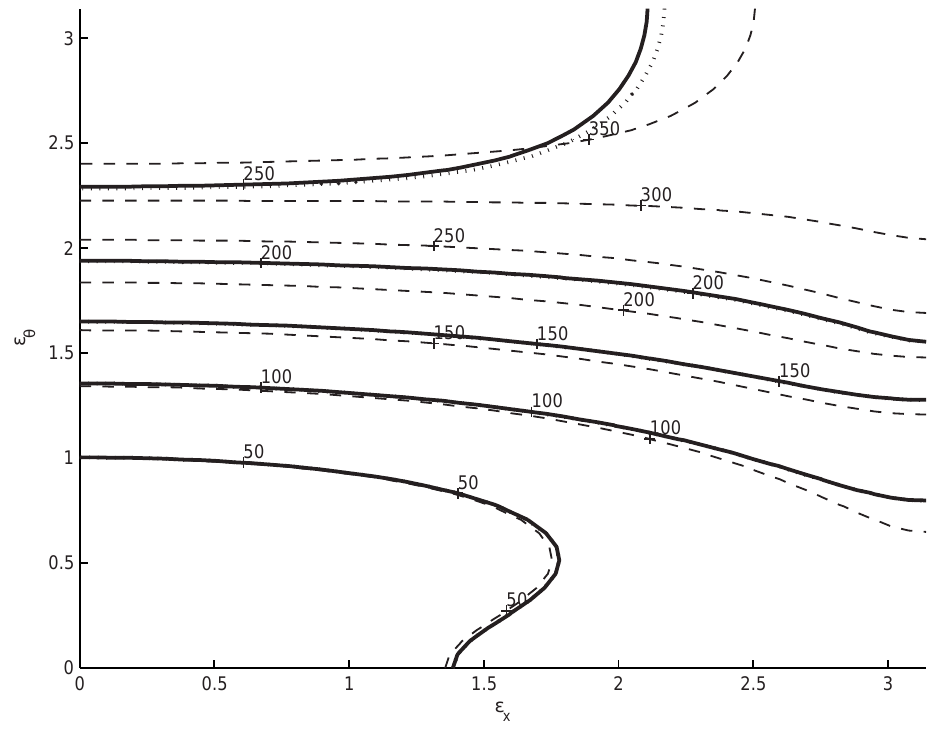
Fig. 7. Convergence of phase constant